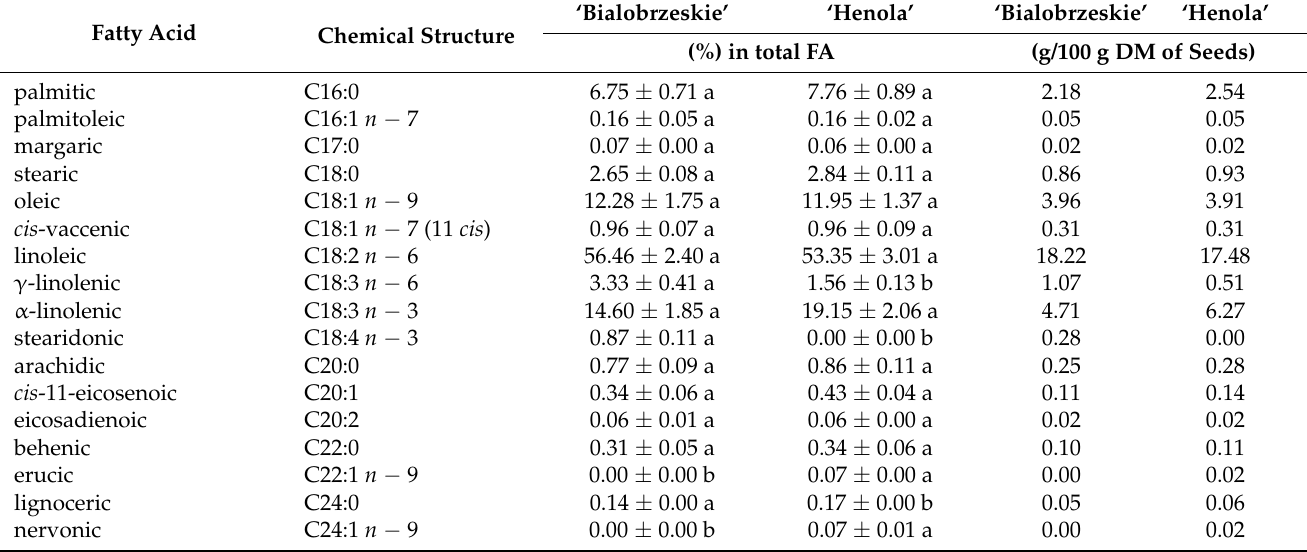
Table 2. Fatty acid (FA) profile/content in hemp